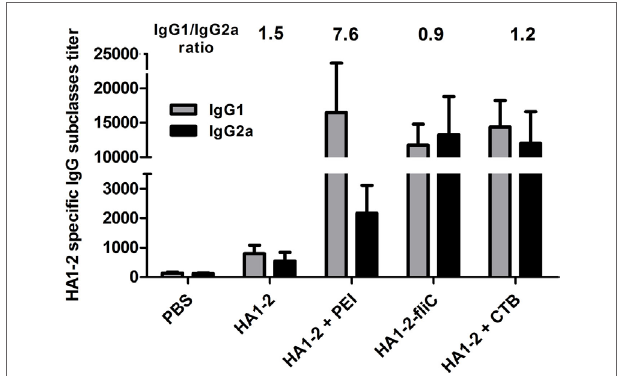
FigUre 3 | ha1–2-specific igg subtype responses to candidate vaccines . C3H/HeJ mice ( n = 6 per group) were vaccinated intranasally with three doses of HA1–2, HA1–2-fliC, PBS, or HA1–2 combined with PEI or CTB. Animals were bled 12 days after the third immunization and HA1–2- specific IgG subtype (IgG1 and IgG2a) titers were measured by ELISA.